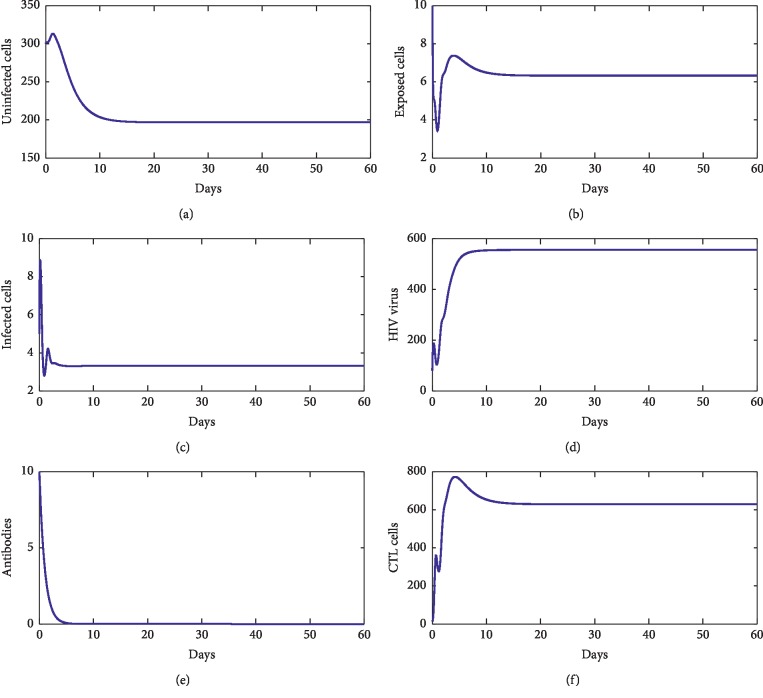
The behavior of the disease for λ=10, d1=0.0139, k1=0.05, d2=0.0495, k2=1.1, d3=0.5776, a=100, d4=0.6, q=0.05, g=10−11, h=0.1, p=0.0024, c=0.15, and b=0.5.